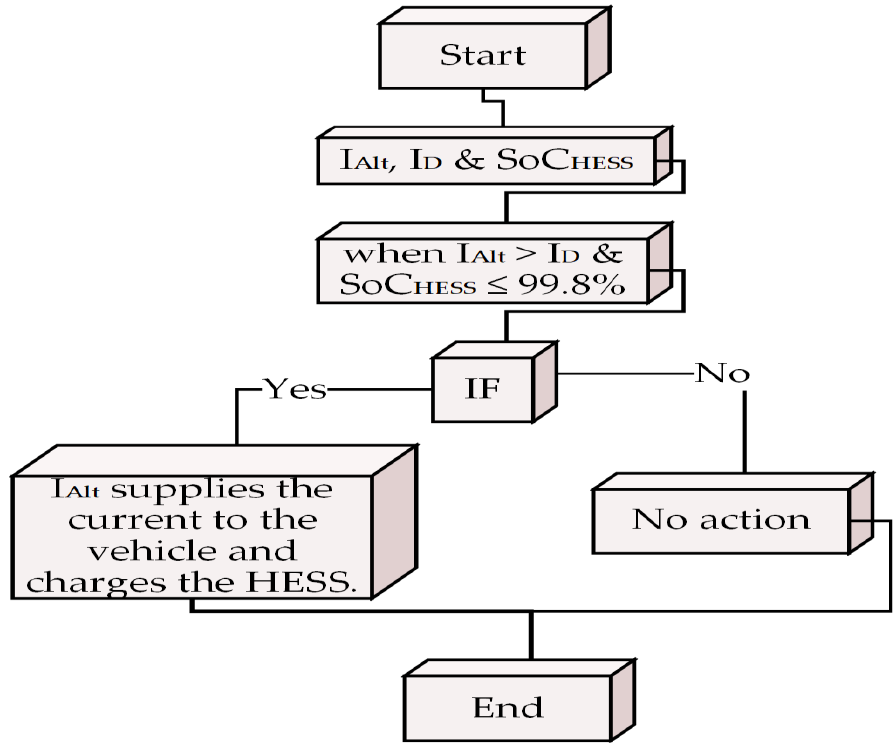
Figure 3. Logic flow chart of the proposed rule-based BMS for HESS during charging mode operation, Reproduced from [37] .